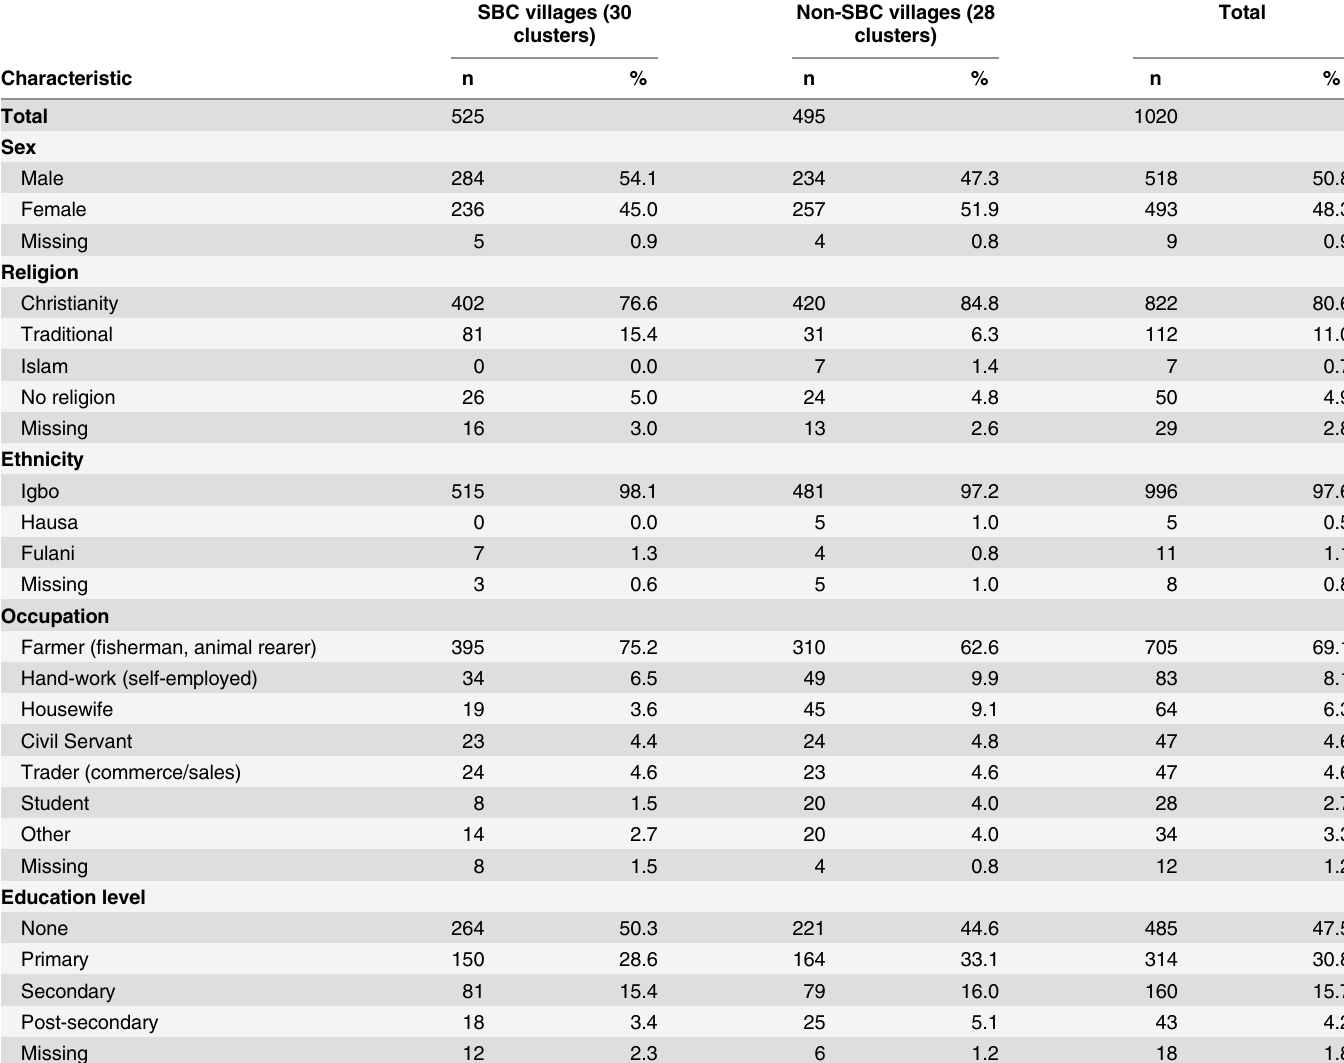
Table 2. Demographic data of respondents who completed the extended KAP survey